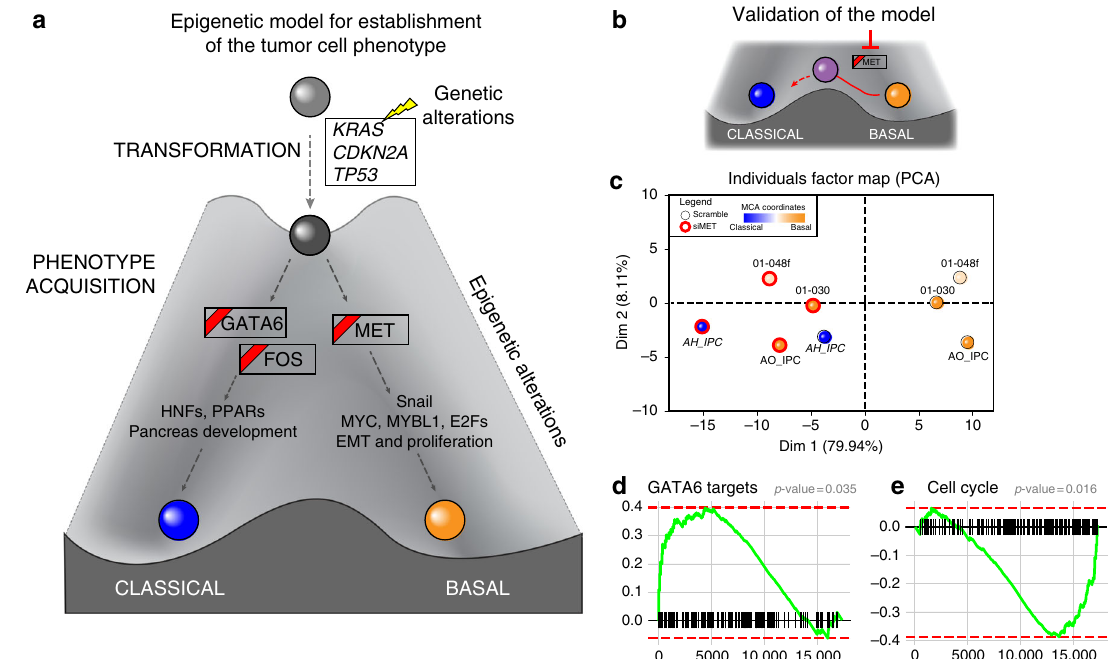
Fig. 5 Epigenetic model for the tumor phenotype and its validation. a Genes that are in a box with red ribbon correspond to genes having an associated Super-enhancer. Yellow fl ash corresponds to genetic alterations. b Diagram is shown of the design for validating the model through inhibition of MET by siRNA to test the potential conversion of a basal to classical cellular phenotype. c PCA based on the differentially expressed genes from RNA-seq on basal siMET and basal control (scramble siRNA) samples. Basal samples were used as active individuals in the PCA construction, whereas the pure classical sample was projected on the two fi rst dimensions. d GSEA plot is shown for GATA6 targets with vertical black lines corresponding to GATA6 putative targets ordered by their statistical tests of the differential analysis between siMET vs. control in basal samples. The curve illustrates the running enrichment score for the gene set ranked by the difference between the cohorts, showing global upregulation of GATA6 targets in the siMET condition. e GSEA plot for cell cycle is shown with vertical black lines corresponding to cell cycle genes (mitotic cell cycle, Reactome) ordered by their statistical tests of the differential analysis comparing siMET vs. control in basal samples. Green curve represents the running enrichment score for this gene set across the ranked list, which demonstrates global downregulation of those genes in the siMET